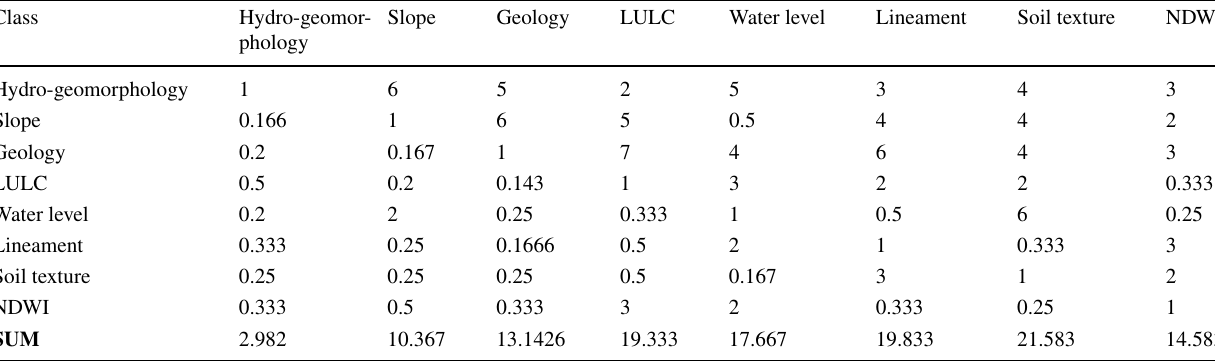
Table 1 Pairwise comparison matrix of eight variables